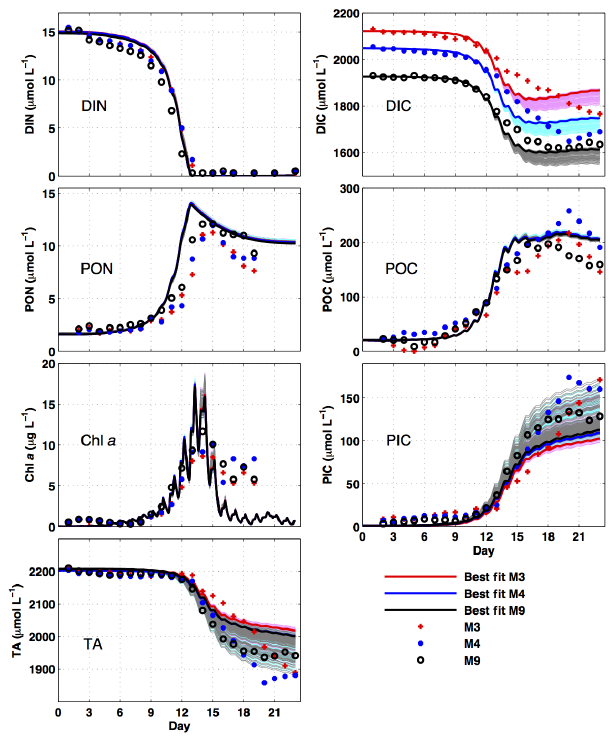
Figure 8. High calcification solution. The coloured bands represent ensemble of model results according to the posterior and symbols show observations.